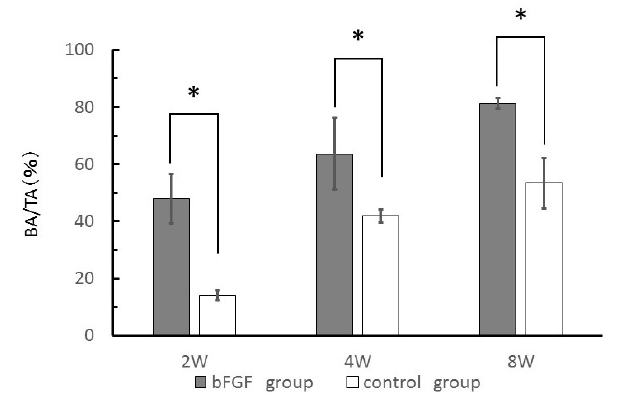
Figure 6. Quantification of new bone growth by measuring new bone area to total area (BA/TA) (%) from H&E-stained sections. * p < 0.05.